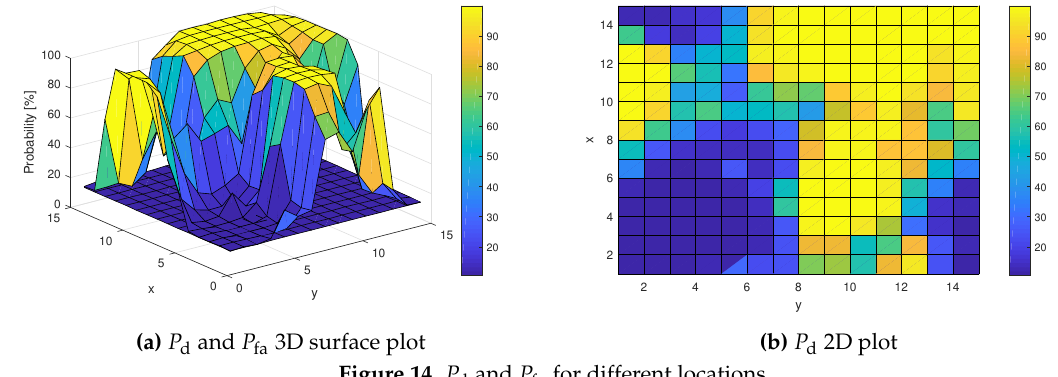
Figure 14. P d and P fa for different